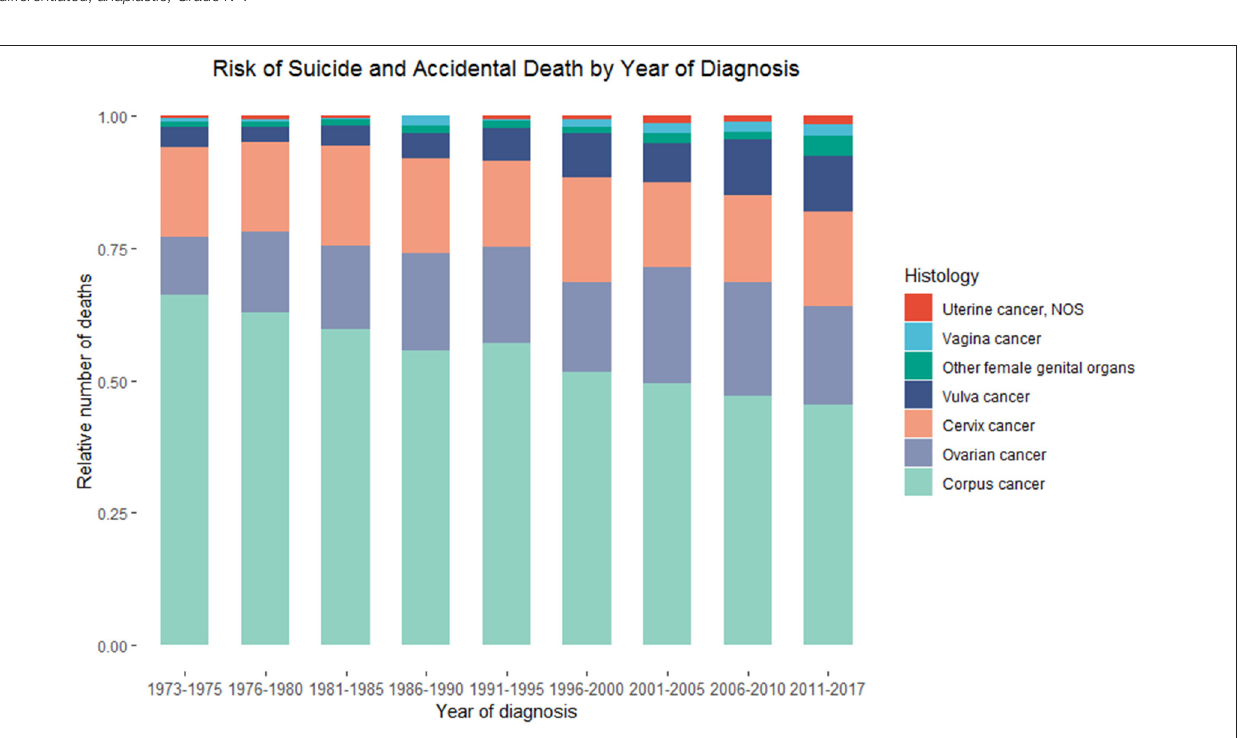
more than 50 years old, the suicide risk gradually decreased with age but increased after the age of 80. Figure 3 showed the number and proportion of suicides and accidental deaths in patients with ovarian cancer of different histological subtypes at different